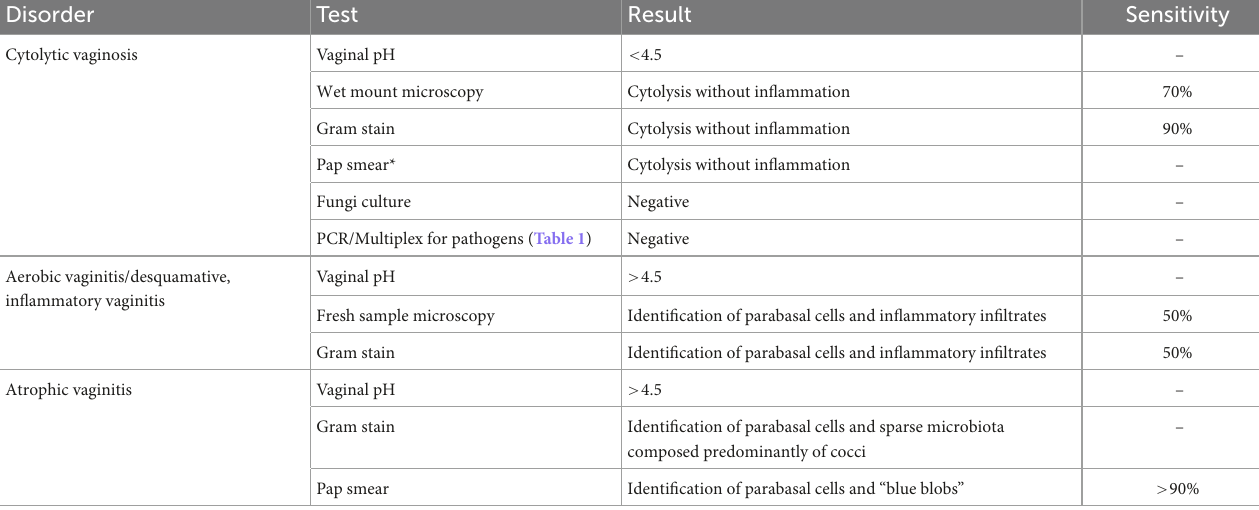
TABLE 1 Laboratory tests for diagnosing infectious microorganisms that may be observed in vaginitis and cervicitis ( Chlamydia trachomatis , Neisseria gonorrhoeae , and Mycoplasma spp). Agent